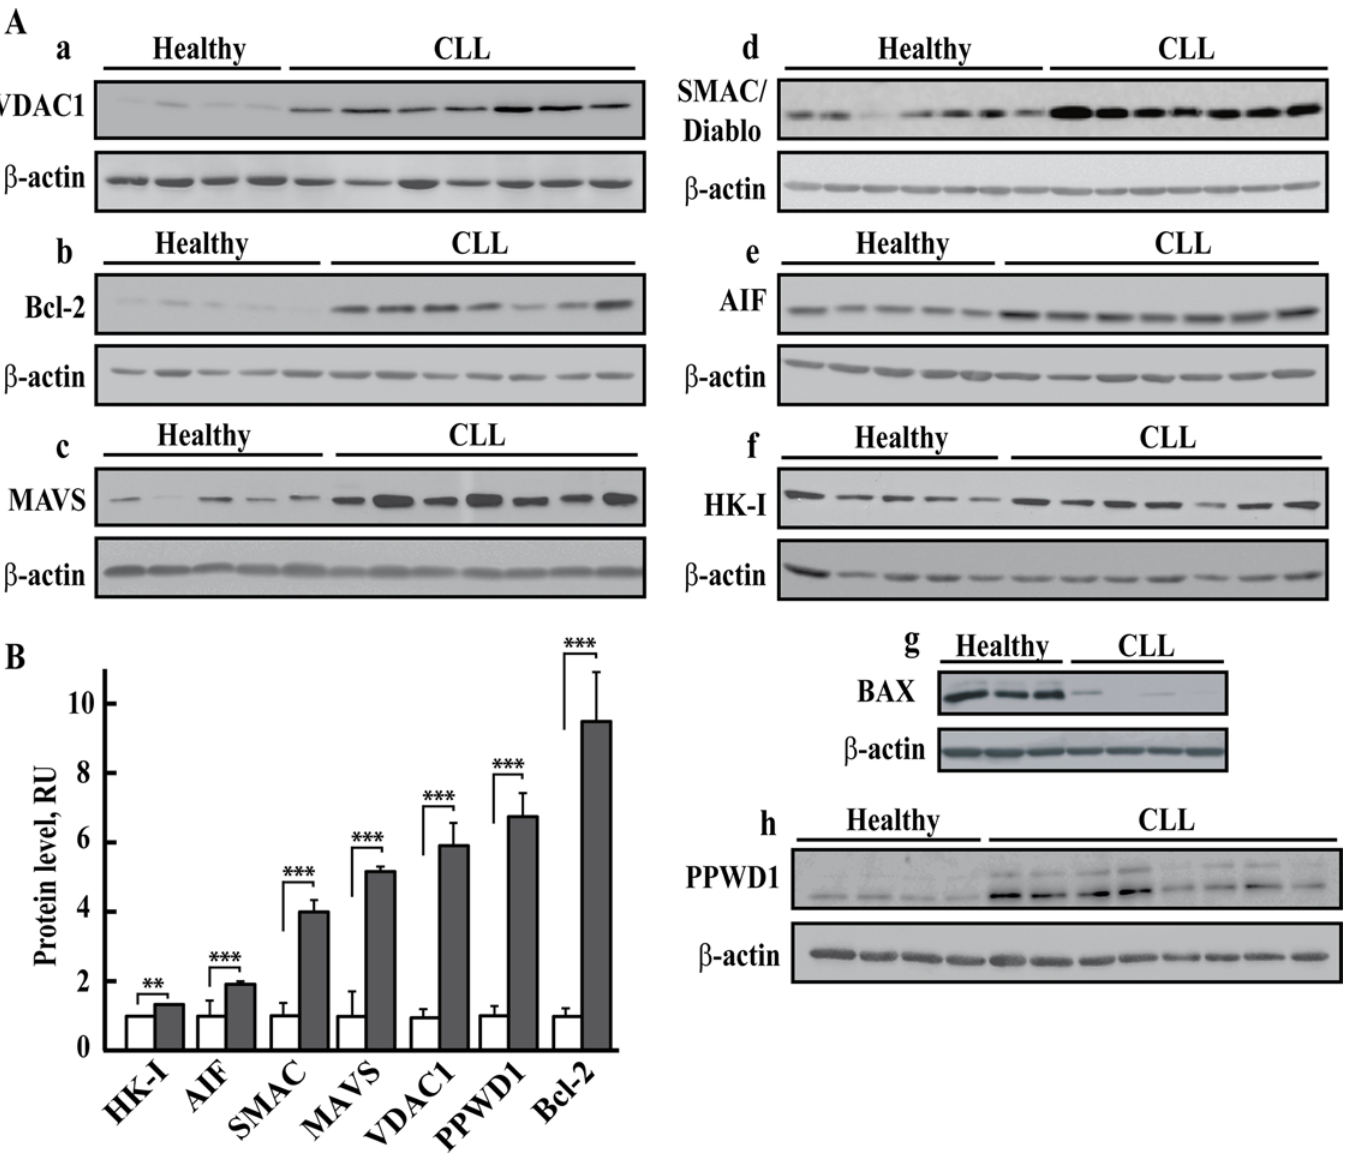
Fig 3. Over-expression of Bcl-2, VDAC, AIF, MAVS, SMAC/Diablo and PPWD1 in PBMCs from CLL patients. Immunoblot analysis of cell lysates of PBMCs derived from CLL patients (P) and healthy donors (H) probed with antibodies directed against VDAC1 [A a , n = 28 (P), 20 (H)], Bcl-2 [A b , n = 28 (P), 20 (H)], MAVS [A c , n = 28 (P), 19 (H)], SMAC/Diablo [A d , n = 21 (P), 15 (H)], AIF [Ae, n = 17 (P), 16 (H)], HK-I [A f , n = 28 (P), 20 (H)], BAX [A g , n = 6 (P), 6 (H)], PPWD1 [A h , n = 16(P), 10(H)] or β -actin. Representative immunoblots ( A ) and quantitative analysis (mean ± SEM) ( B ) of protein levels of healthy donors (white) and CLL patients (grey) of these and other samples are presented. For each sample, three independent immunoblots were performed. A difference between healthy and CLL groups was considered statistically significant when P < 0.001 ( *** ) or P < 0.01 ( ** ), as determined by the Mann- Whitney